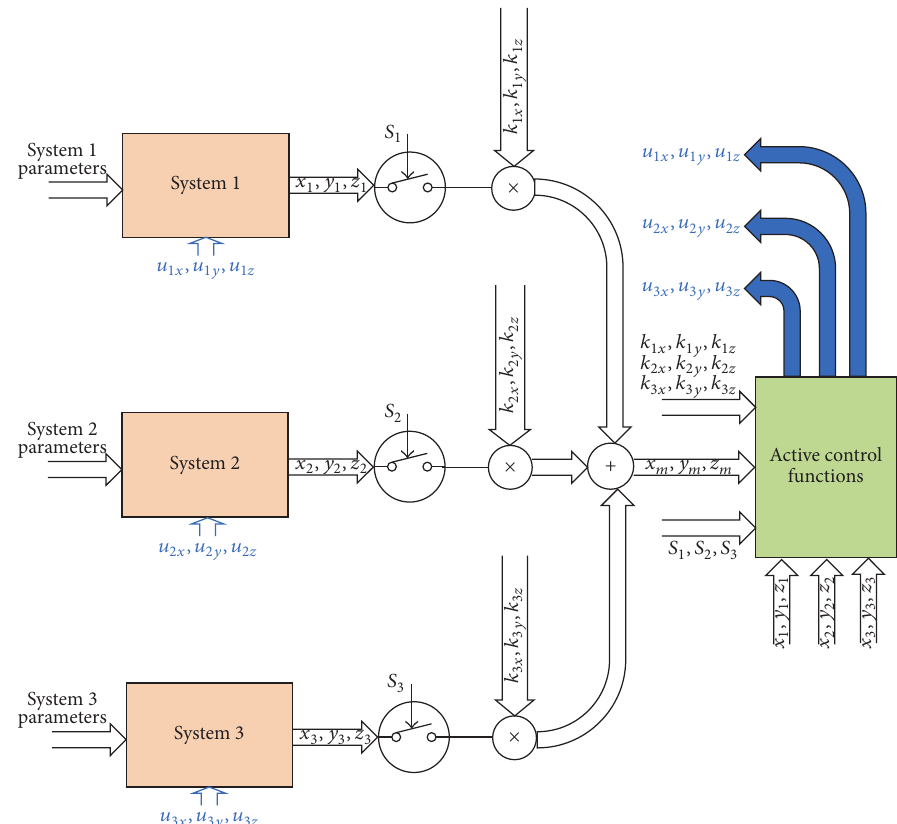
Figure 2: Block diagram of the generalized dynamic switched synchronization of three fractional-order chaotic